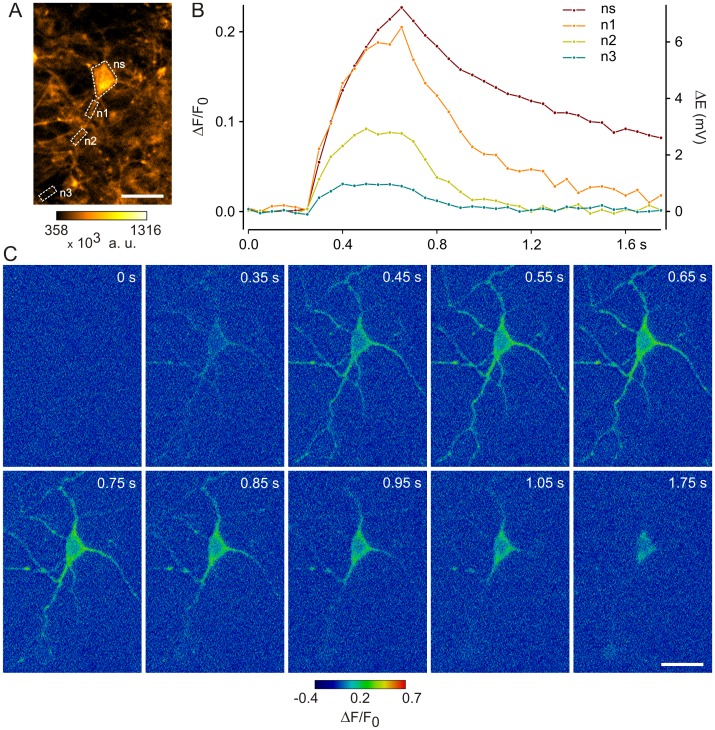
Monitoring of spontaneous neuronal activity with FMP.(A) FMP fluorescence in hippocampal neurons. The image shows the basal FMP fluorescence (530 nm excitation; 605 nm emission). Regions of interest on the neuronal soma (ns) and along neurites (n1–n3) are marked. Scale bars, 20 µm. (B) Time courses of ΔF/F0 recorded on the neuronal soma and neurites as indicated in A. The signals were calibrated with eq. 9. z′ = −0.72. RT/F = 25.43 mV (22°C). Images were sampled at a rate of 20 frames/s. (C) Single frames of neuronal activity recorded at the indicated time points. Images of relative FMP fluorescence (ΔF/F0) were computed pixel-by-pixel.